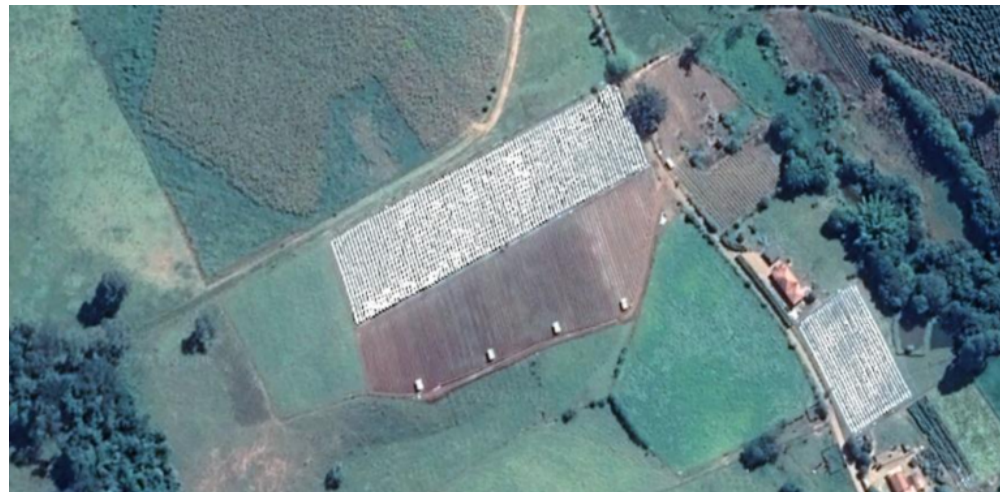
Figure 13. Total area of the plantation.